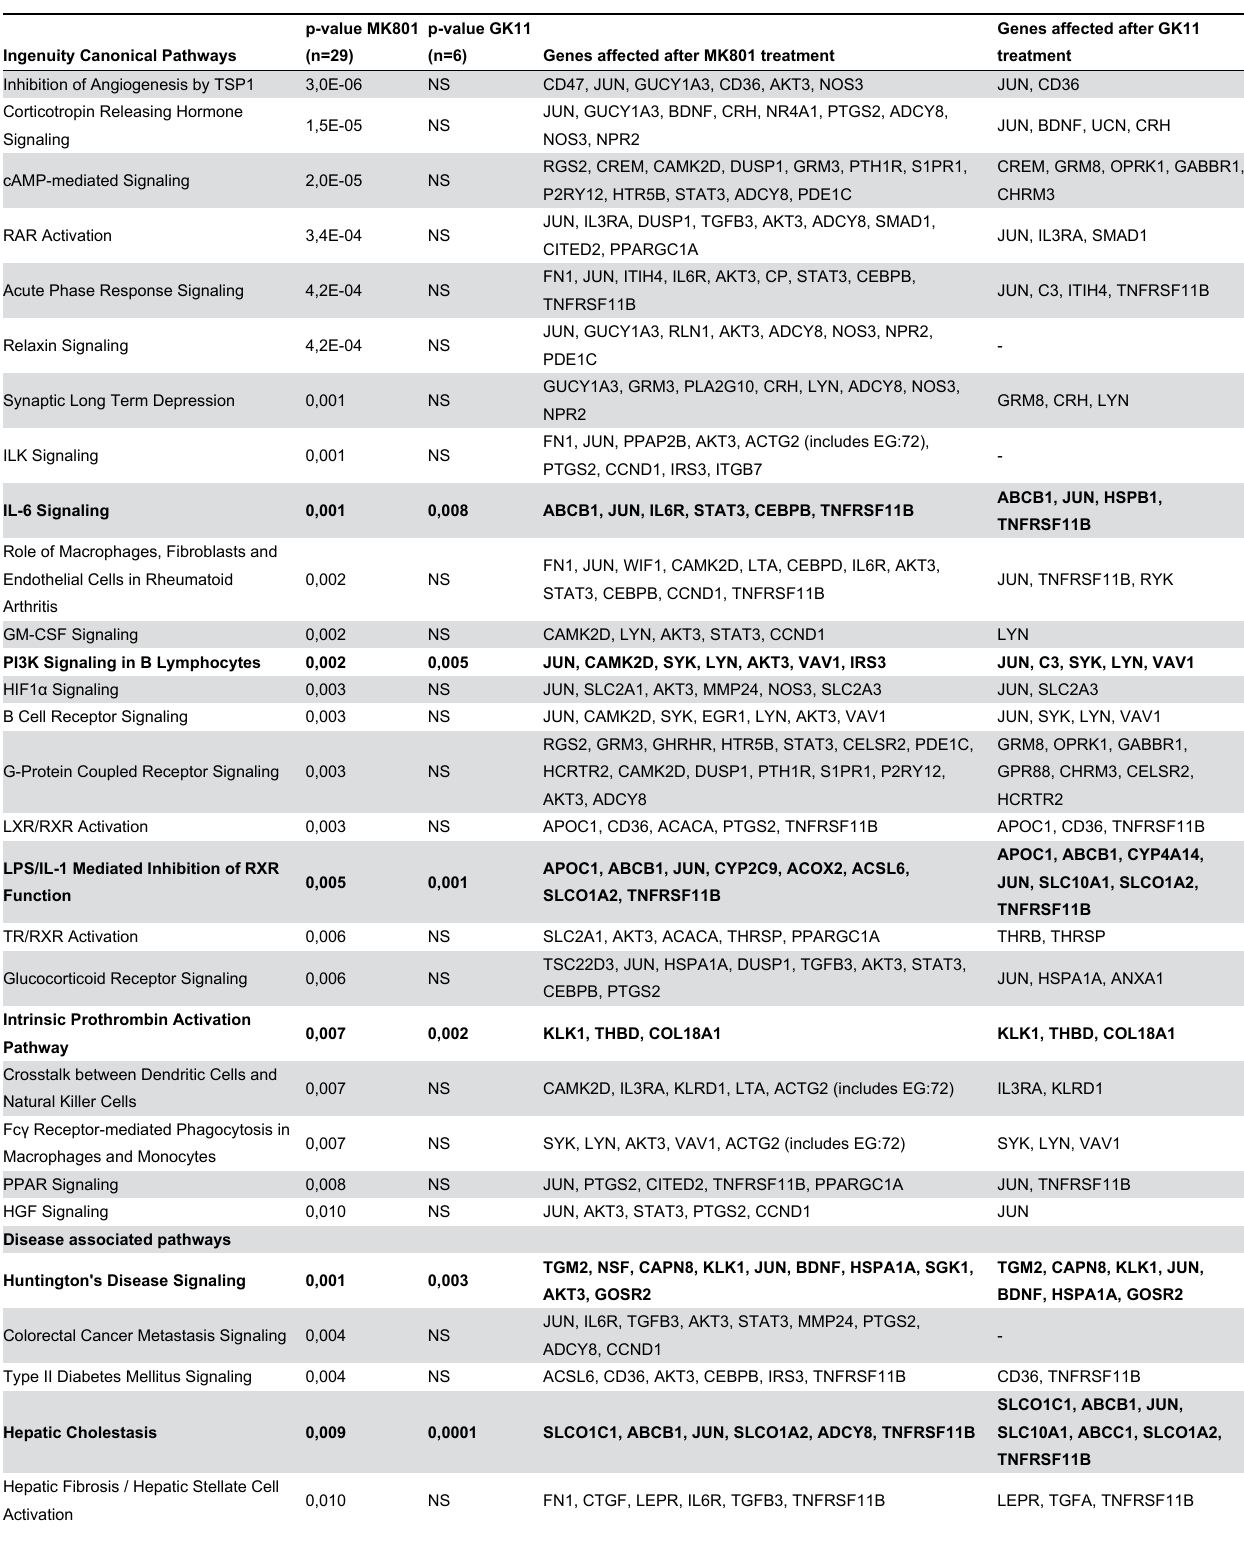
Table 2. List of the most changed canonical pathways (IPA p-value <0.01).